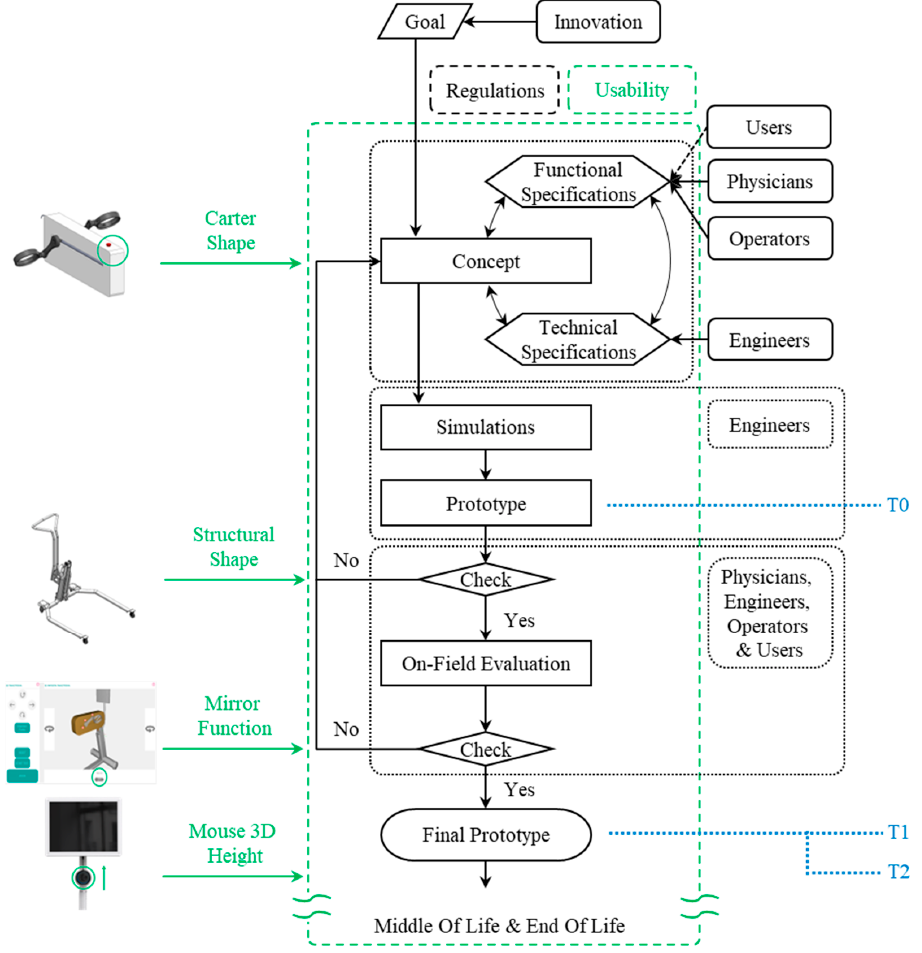
Figure 7. LEPRE Case Study: Application of the Usability-Oriented Model for the Design of Medical Devices.